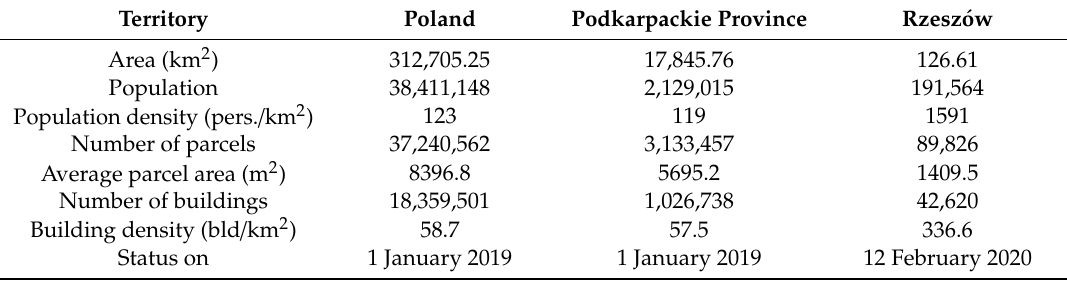
Table 1. Characteristics of Rzeszów in comparison with the region and the country.